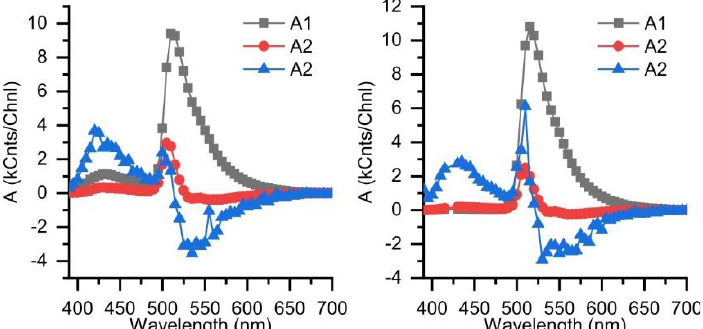
Figure A2. Spectra of amplitudes A 1 – A 3 obtained from global fitting of time-resolved fluorescence spectra of 11 in dichloromethane ( left ) and toluene ( right ) λ ex = 375 nm.